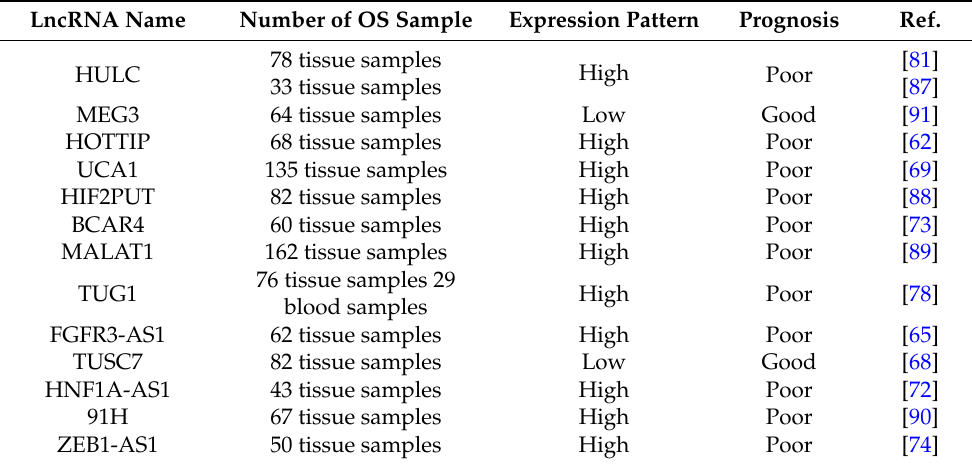
Table 3. Long non-coding RNAs associated with prognosis of